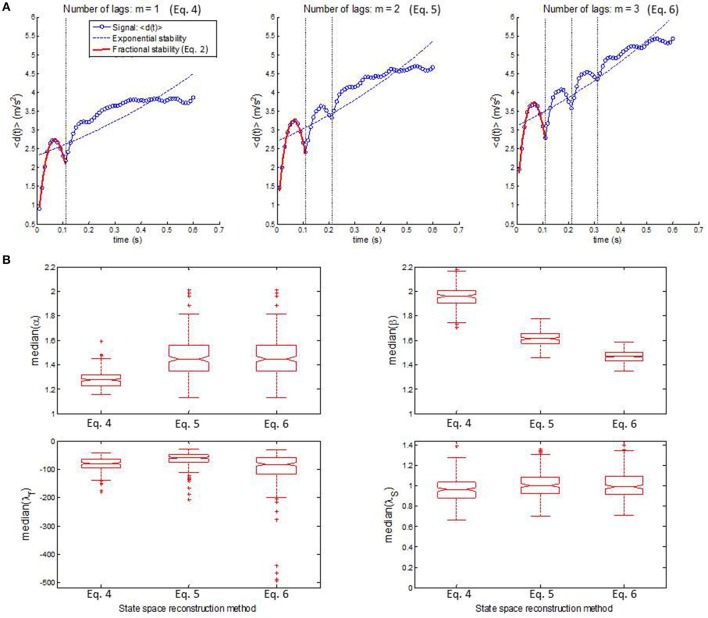
(A) Representative example of fractional stability in Equation (2) (bold red lines) fitted to the d(t) (blue dots) for state space reconstruction in Equation (4) (left), Equation (5) (middle), and Equation (6) (right). Fractional stability in Equation (2) represented a considerable improved model of d(t) compared to exponential stability d(t) = d(0)exp(λSt) (dashed blue lines) for all state space reconstruction methods. (B) Boxplots of the median values of the fractional stability parameters, α (upper left), β (upper right), and λf (lower left) together with median values of exponential stability λS (lower right). Note that the center of the box represents the median and the upper and lower borders of the box represent the 75th and 25th percentile, respectively. The whiskers represent the most deviating values within 1.5 times the interquartile range from the median value whereas values outside this range are represented as outliers.